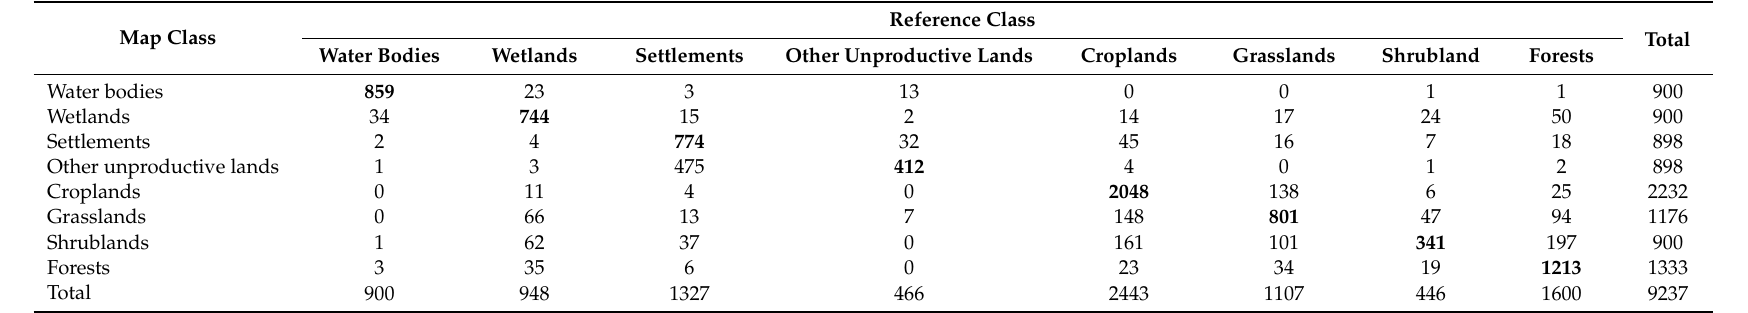
Table 4. The error matrix of Landsat-derived land cover classification over flatland